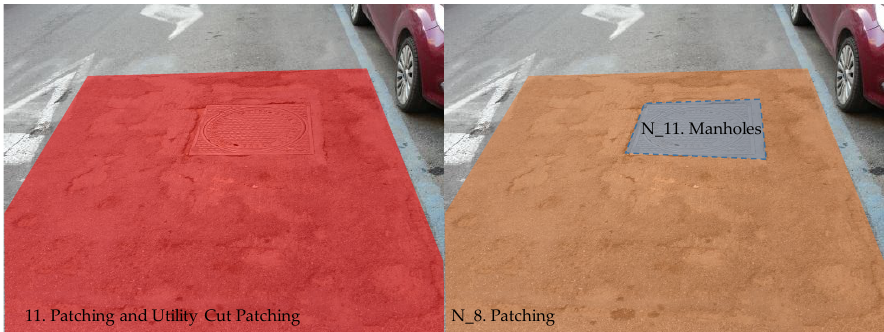
Figure 8. Example of manhole distress identification guidelines. Table 8. Comparative analysis between ASTM D6433 and New Distress Identification Manual for Urban Pavements: N_11 Manholes .